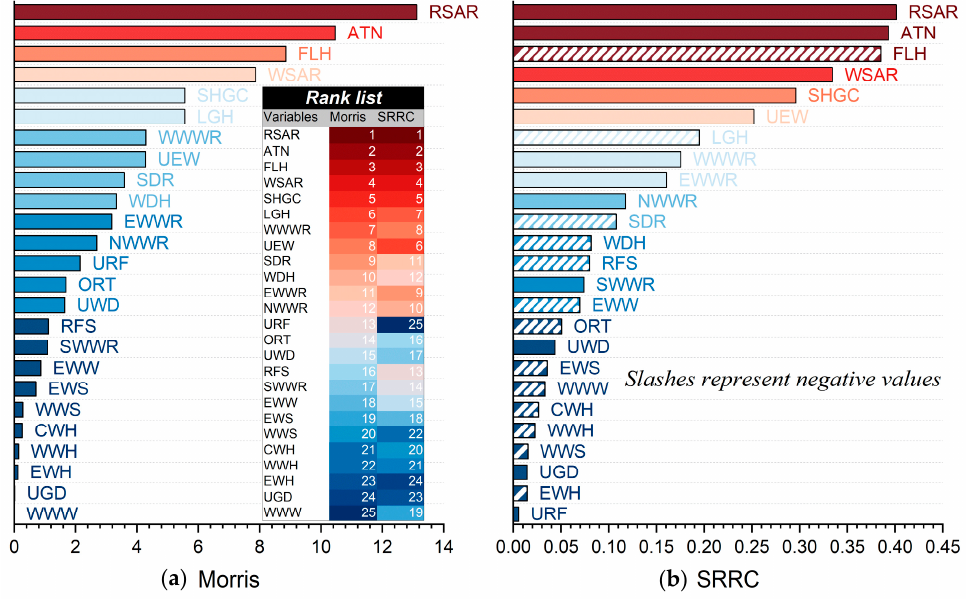
Figure 6. Ranking of sensitivity parameters to cooling demand obtained by the two methods in the first-stage SA: ( a ) Morris (left); ( b ) SRRC (right).